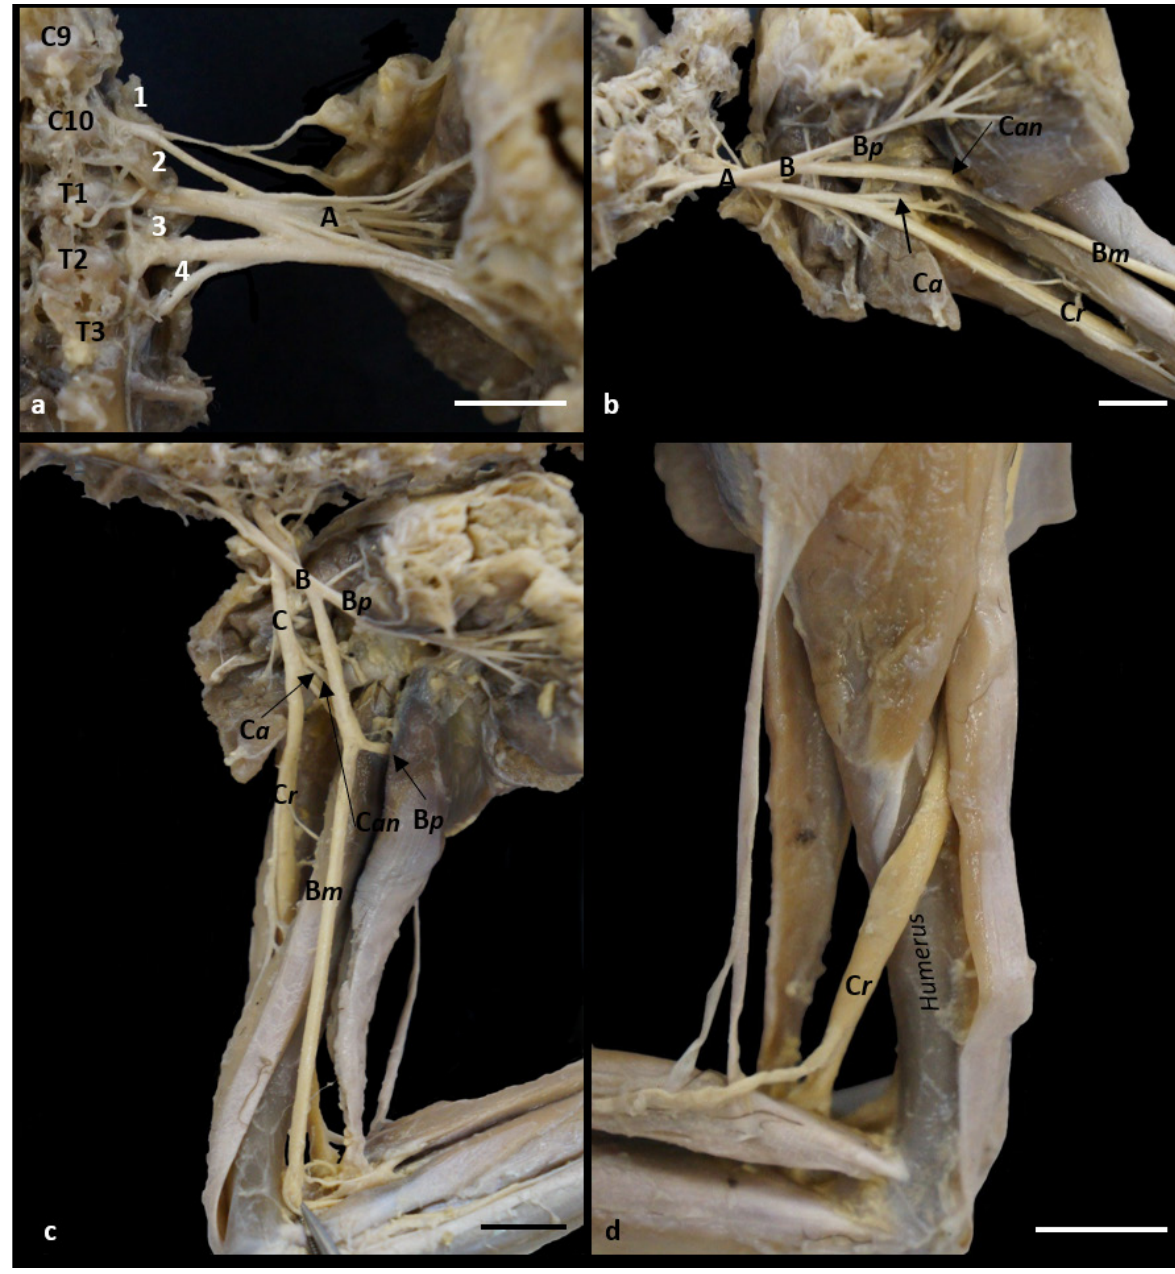
Figure 1. Photomacrographs of the brachial plexus of the roadside hawk ( Rupornis magnirostris ). a-b: ventral view; c: medial view; d: side view. Scale bar: 1.0cm. Legend: C9- Ninth cervical vertebra, C10- tenth cervical vertebra, T1- first thoracic vertebra, T2- second thoracic vertebra, T3- third thoracic vertebra, 1- origin of first short nerve trunk, 2- origin of the second short nerve trunk, 3- origin of the third short nerve trunk, 4- origin of the fourth short nerve trunk, A- short trunk; B- ventral branch, Bm- median-ulnal nerve, Bp- bicipital nerve, C- dorsal branch, Ca- axillar nerve, C an - anconal nerve, Cr - radial